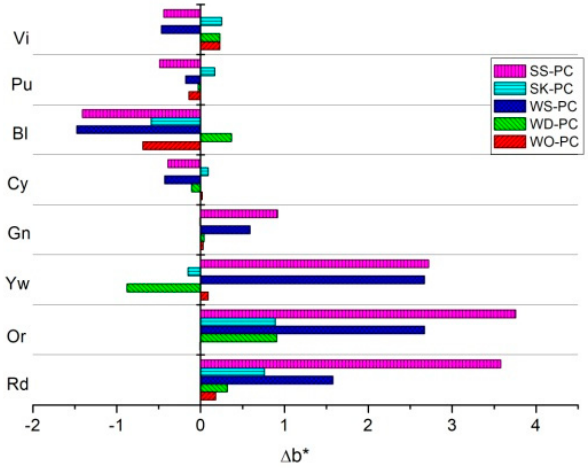
Figure 4. Δ b* calculated using PC adjustment as the target and other adjustment conditions as samples.